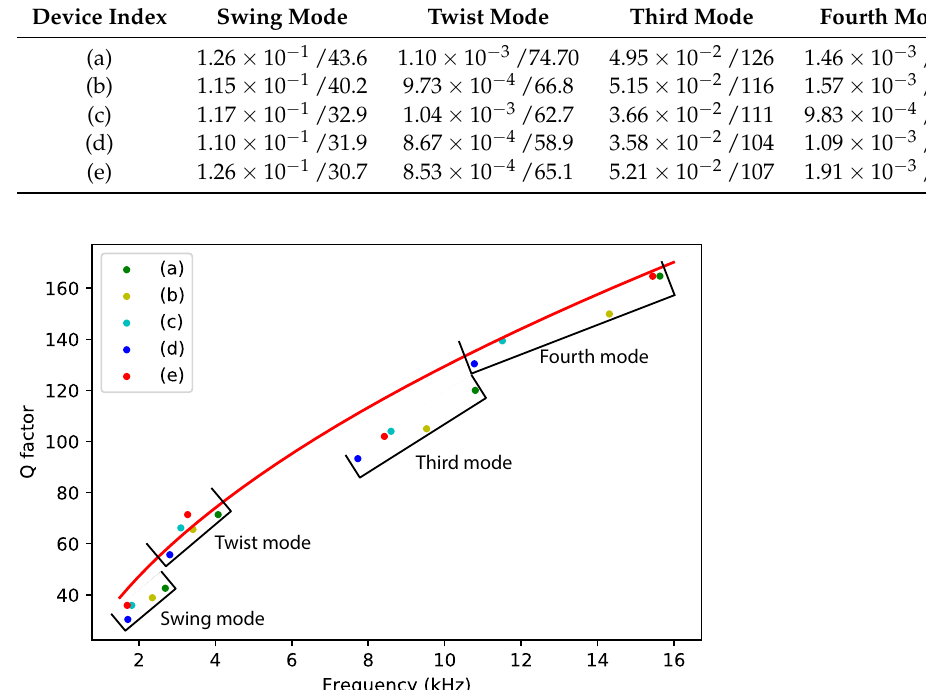
Figure 11. Measured and theoretically predicted Q factor as a function of resonance frequency. Measurement points with the same color represent measurement results from the same device. The red line represents the Q factor calculated from Equation